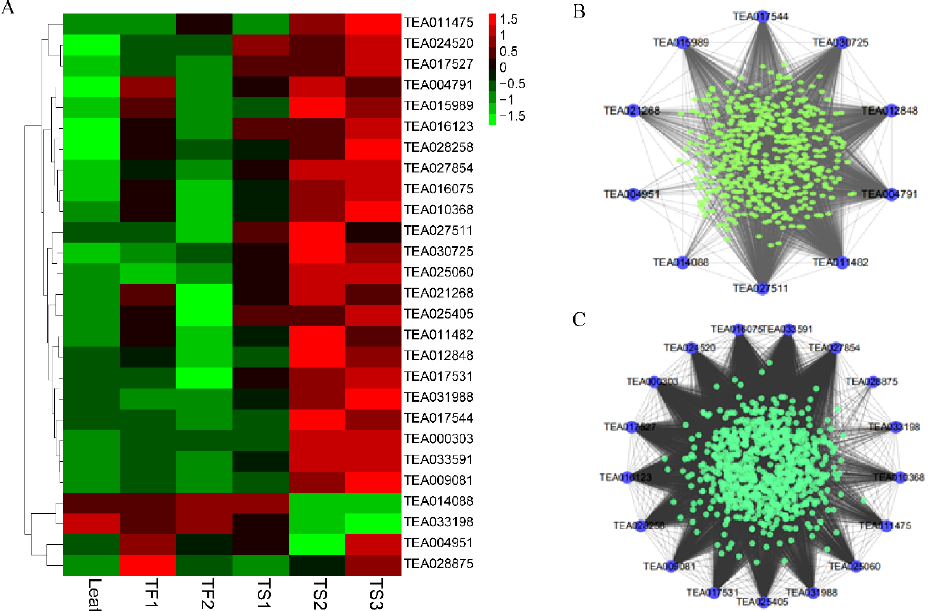
Figure 5. Analysis of hub TFs in black and red modules. ( A ) Heatmap displaying the expression patterns of all hub TFs in different samples. ( B ) The transcriptional regulatory network of the hub TFs in the black module. ( C ) The transcriptional regulatory network of the hub TFs in the red module.